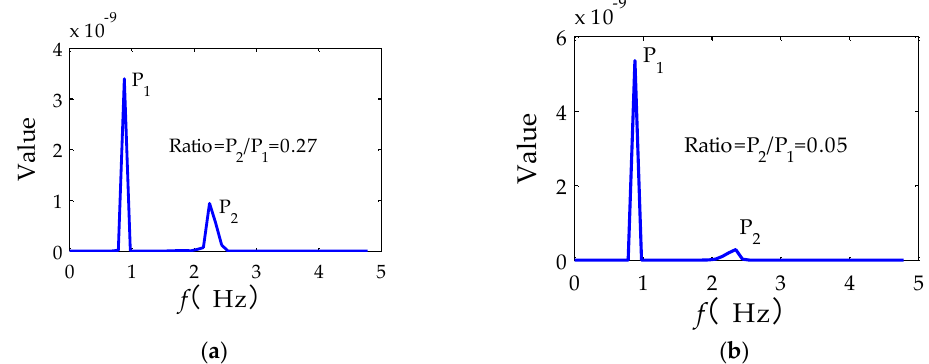
Figure 9. ( a ) The power spectrum with signal-to-noise ratio (SNR) of 0.015; ( b ) the power spectrum with signal-to-noise ratio (SNR) of 0.3.